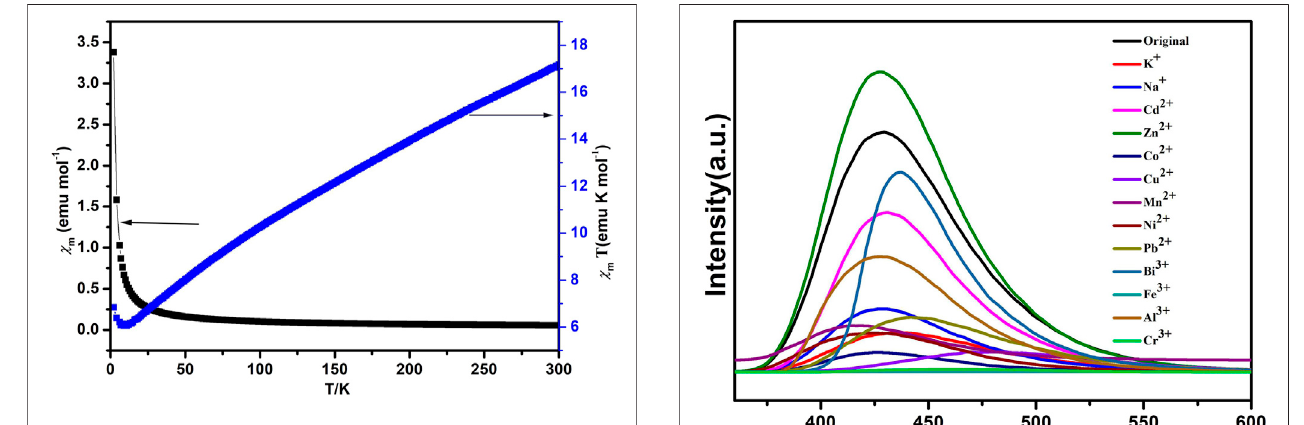
FIGURE 5 | Magnetic susceptibility of compound 1 plotted as χ m vs. T (black) and χ m T vs. T curves (blue).